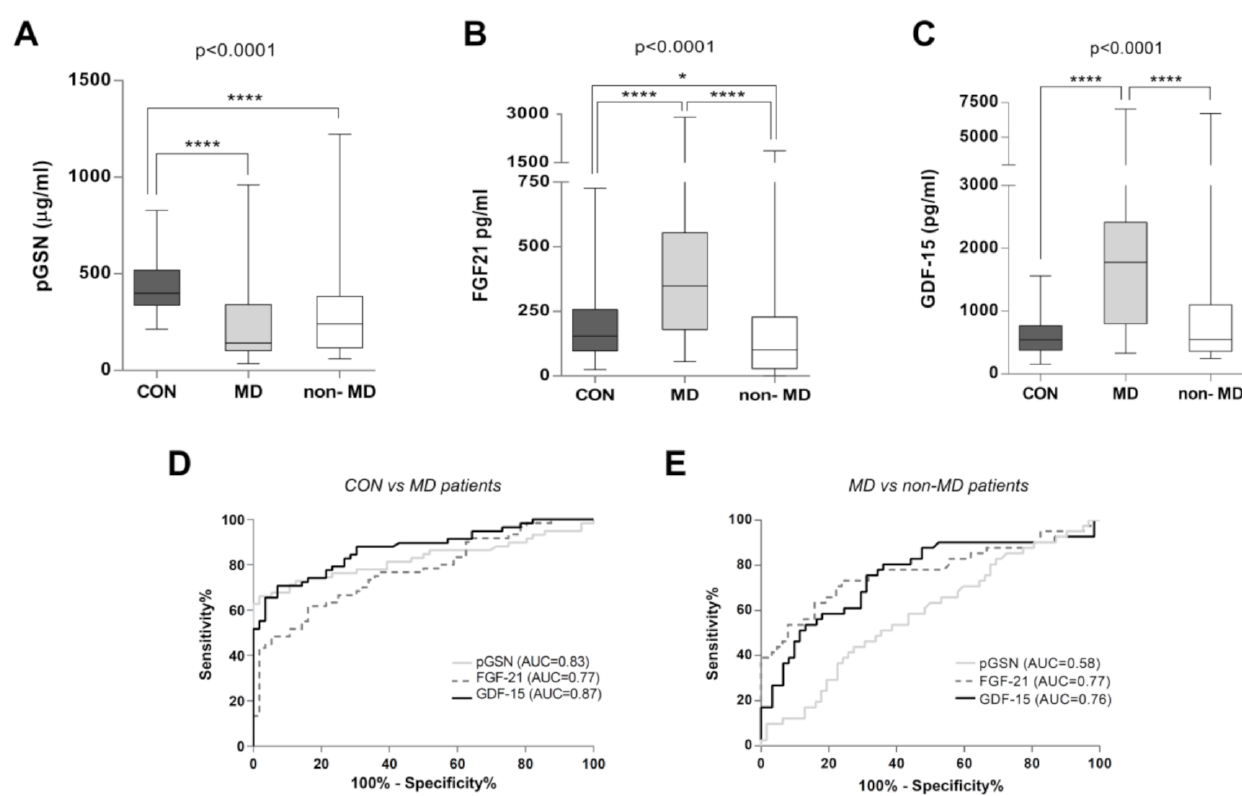
Figure 2. Plasma concentrations of pGSN, FGF-21, and GDF-15 in healthy controls, mitochondrial (MD), and non- mitochondrial patients (non-MD). ( A ) pGSN concentration is significantly decreased in MD and non-MD patients. ( B ) FGF-21 concentration is significantly increased in MD patients. ( C ) GDF-15 concentration is significantly increased in MD patients. For ( A – C ): Data represent the average biomarker concentration in healthy controls (CON, n = 56), MD ( n = 60), and non-MD ( n = 41) subjects. Data are presented as the median, interquartile range, minimum, and maximum. Kruskal–Wallis test p -values for the different groups are indicated in the figures. Post hoc Mann–Whitney U test p -values: **** p < 0.00001, * p < 0.05. For ( D , E ): Global ROC curves. Comparative ROC curves for pGSN, FGF-21, and GDF-15 in the full study cohorts, regardless of their age. ( D ) ROC curve in MD patients vs. healthy controls. AUC values were 0.83 for pGSN (CI: 0.75–0.91), 0.77 for FGF-21 (CI: 0.68–0.86), and 0.87 for GDF-15 (CI: 0.81–0.93). ( E ) ROC curve in MD patients vs. non-MD patients. AUC values were 0.58 for pGSN (CI: 0.47–0.70), 0.77 for FGF-21 (CI: 0.67–0.87), and 0.76 for GDF-15 (CI: 0.66–0.86). AUC = area under the curve; ROC = receiver operating characteristic; CI: confidence